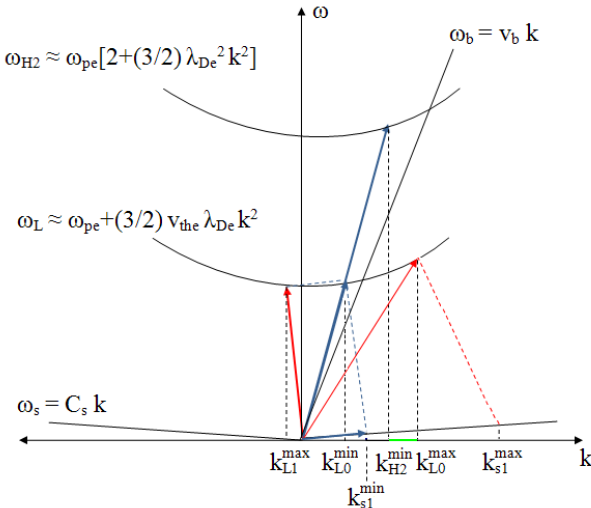
Fig. 3. Schematic of the simultaneous detection of enhanced IAW, LW and the first Langmuir harmonic. The maximum (red color) and minimum (blue color) waves follow the definitions presented in Eqs. 30. The decay process of L 0 with k L 0 ∈ [ k min L 0 ,k max L 0 ] ( k min L 0 → k max L 1 + k min s 1 and k max L 0 → k min L 1 + k max s 1 ) lo- cates k s 1 ∈ [ k min s 1 ,k max s 1 ] . The dispersion relation of the beam locates k H 2 ∈ [2 k min L 0 , 2 k max L 0 ] . If the con- dition v b ≥ 1 / 3∆ v b is satisfied, which ensures that k min L 0 ≤ k min s 1 ≤ k min H 2 ≤ k max L 0 ≤ k max s 1 , then multi- ple detection of the enhanced Langmuir, Ion acoustic and first Langmuir harmonic waves is possible for k =2 k radar ∈ [ k min H 2 ,k max L 0 ] (wavenumber interval in green).